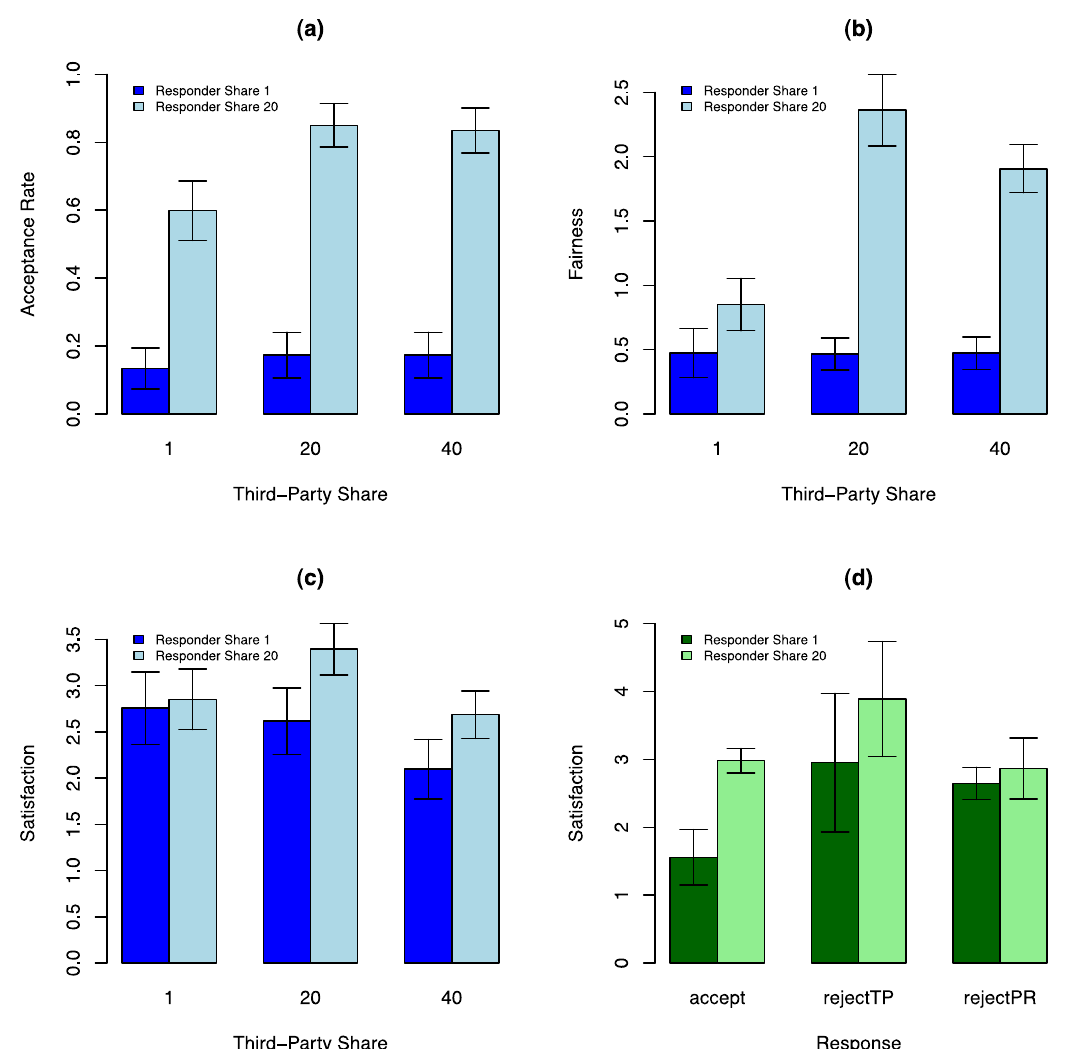
Figure 1. Study 1: ( a ) Acceptance rate; ( b ) Fairness; ( c ) Satisfaction as a function of shares; ( d ) Satisfaction as a function of response. Error bars indicate 95%